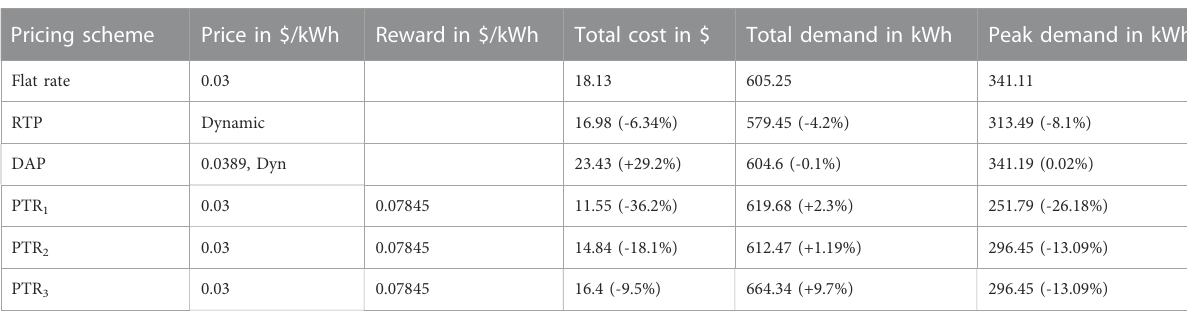
TABLE 4 Results of May 05.